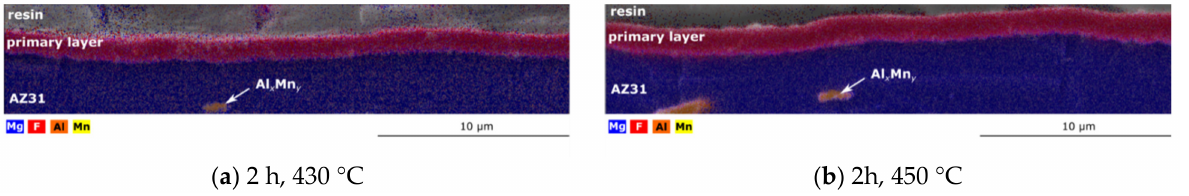
Figure 3. The cross-sections of fluoride conversion coating prepared on AZ31, SEM,